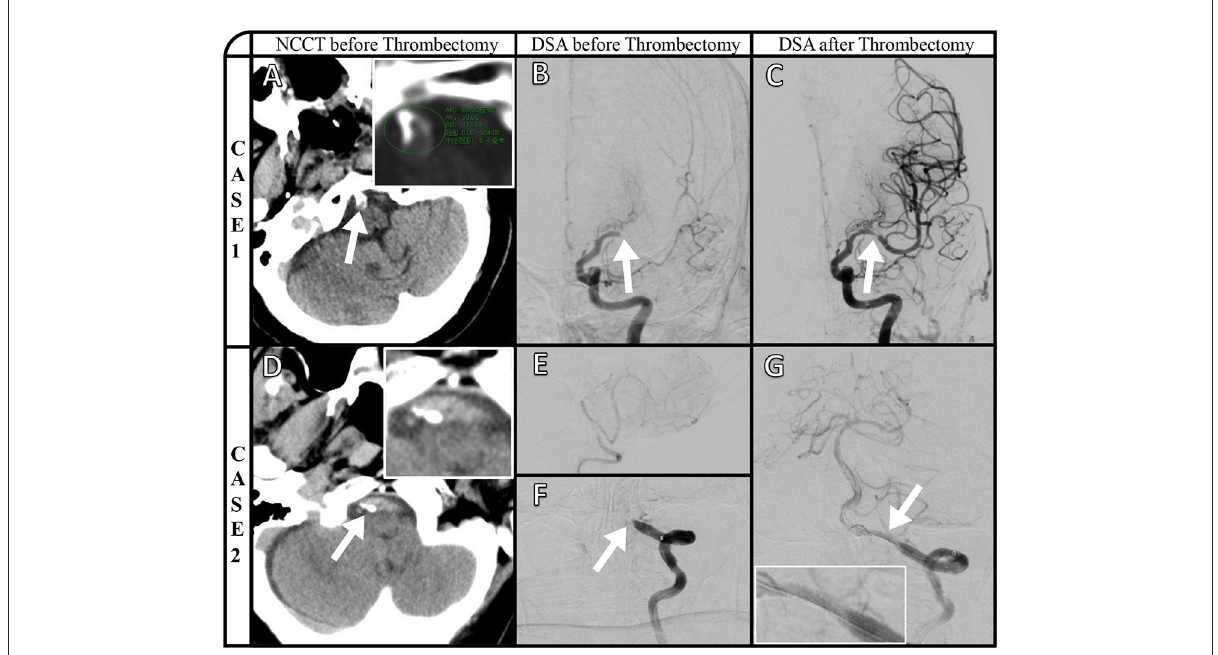
FIGURE2 Representative images of VBAC and ICAS-O in thrombectomy (CASE1 and CASE2). Axial NCCT image (A) and magnified view (insert in A) show basilar artery calcification, and the highest CT value is 564HU. Posteroanterior left internal carotid artery angiography (B) manifested left middle cerebral artery occlusion. The stenosis (C) after thrombectomy demonstrates the etiology is ICAS occlusion. Axial NCCT imaging from a different patient (D) and magnified view (inset in D) show left vertebral artery calcification. Right vertebral artery angiography (E) shows that only supply posterior inferior cerebellar artery, and posteroanterior left artery angiography shows (F) V4 occlusion. The stent (G) and magnified view (insert in G) released in situ ICAS